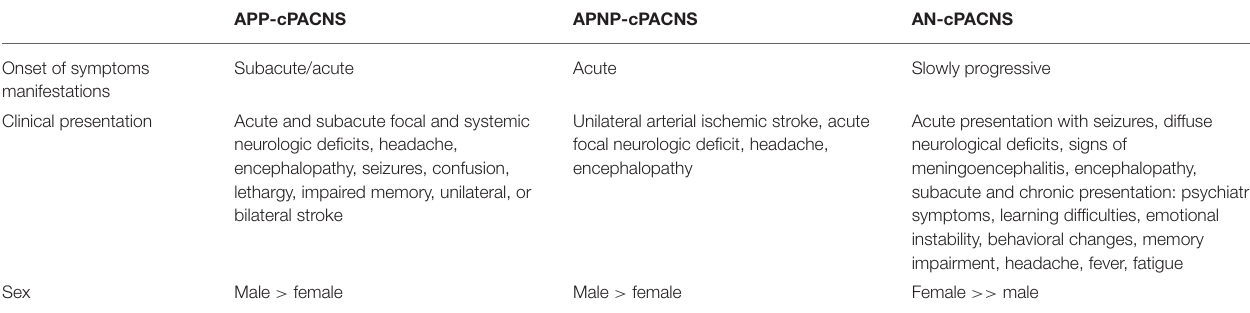
TABLE 1 | Clinical course in medium- to large-vessel (AP-cPACNS) and small-vessel cerebral vasculitis (AN-cPACNS) in